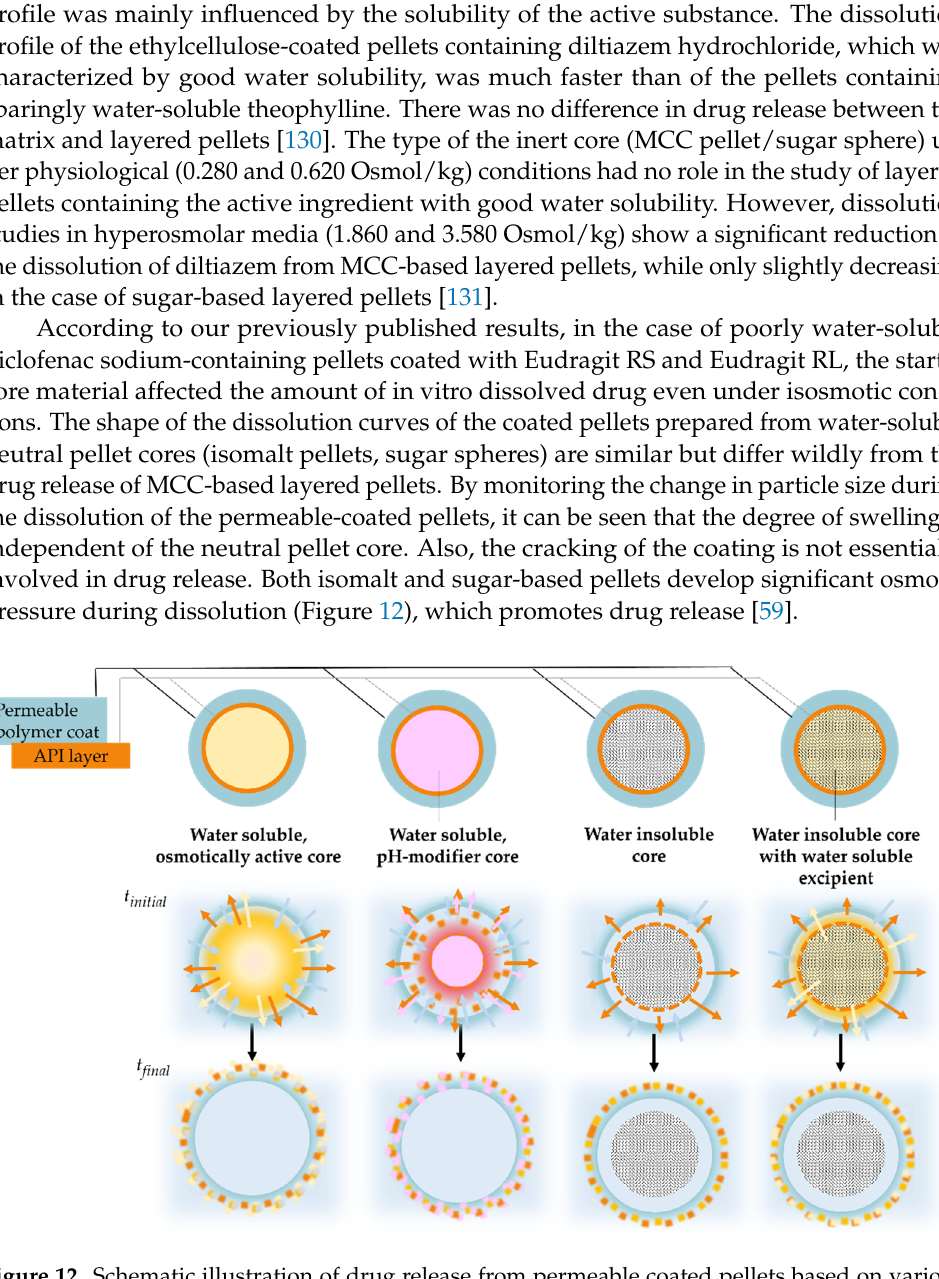
Figure 12. Schematic illustration of drug release from permeable coated pellets based on various starter cores. starter